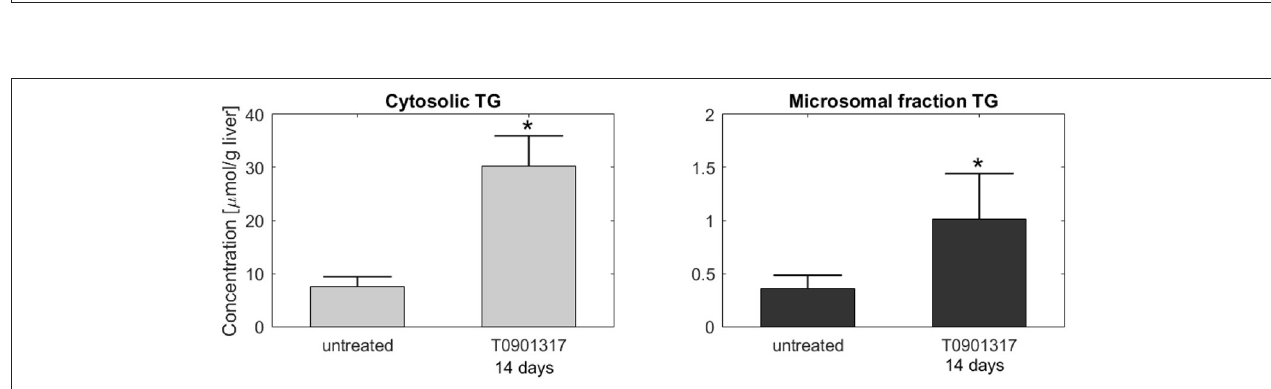
FIGURE 6 | Fractionation of hepatic triglycerides. Additional measurements were performed on livers from C57BL/6J mice treated with T0901317 for 14 days and untreated controls to separate the cytosolic TG fraction from the microsomal fraction, containing VLDL particles. The experimental data shows that hepatic TG is predominantly stored in the cytosolic fraction, which confirmed the model estimations presented in Figure 5 . Note the 20-fold scale difference in both y-axis. The bars indicate mean + standard deviation, * p < 0.05, Mann-Whitney U -test.